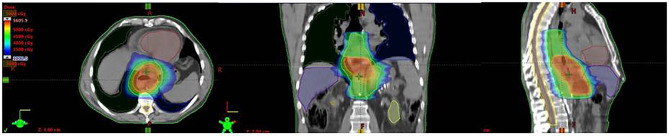
An example of the dosimetric plan with IMRT-SIB of 45–52.5 Gy for EGJ (Siewert 1) adenocarcinoma and normal tissue dose limits. This example demonstrates the coverage of PTV 52.5 Gy (orange) including GTV and PTV 45 Gy (blue), and respect of OARs (Right Lung: green, Left Lung: blue; Hearth: brown, Liver: purple, Spinal cord: light orange and Spinal cord prv: yellow).